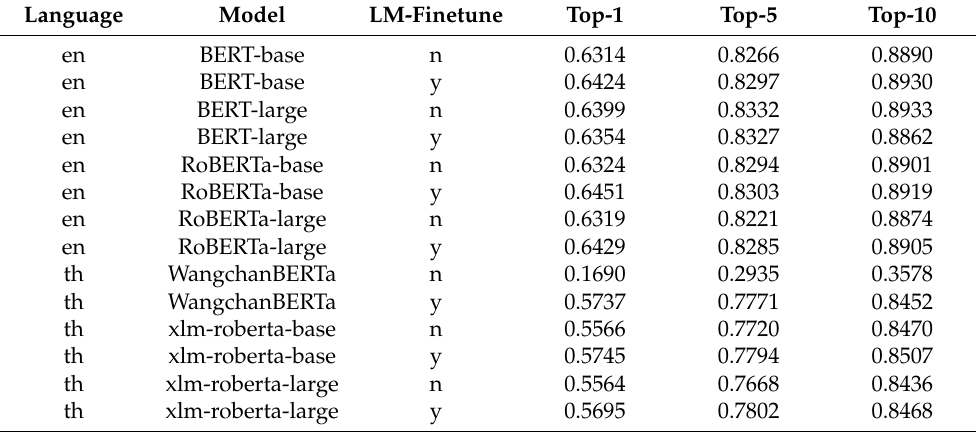
Table 3. The top-k recall value of the supervised model trained with various LM configurations as the initial weight. For the English version, we considered BERT-base ( ≈ 120 M parameters), BERT-large ( ≈ 300 M parameters), RoBERTa-base and RoBERTa-large. For Thai, we considered WanchangBERTa (it does not have a large version), xlm-roberta-base and xlm-roberta-large. For each LM type, both LM-finetuned and not finetuned were considered. It can be seen for every type that LM-finetuning leads to improved recall for all values of k except for BERT-large vs. BERT-base. The best configuration for English was a finetuned RoBERTa-base with 0.6451, 0.8303 and 0.8919 top 1, 5, and 10, respectively. The top-1 value is higher than 0.6363 reported in [19]. For Thai, the best configuration was finetuned xlm-roberta-base.